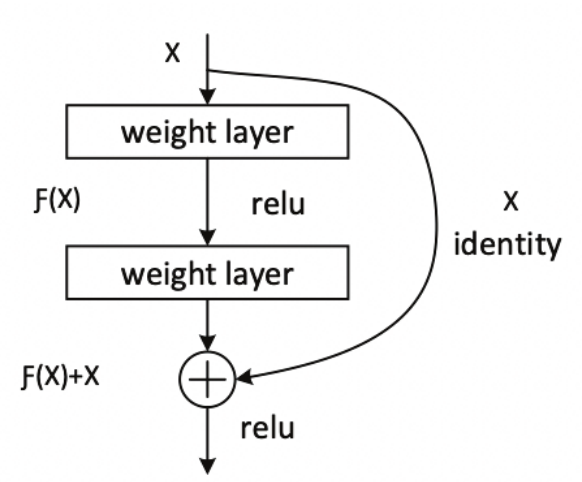
Figure 3: Schematic diagram of a residual